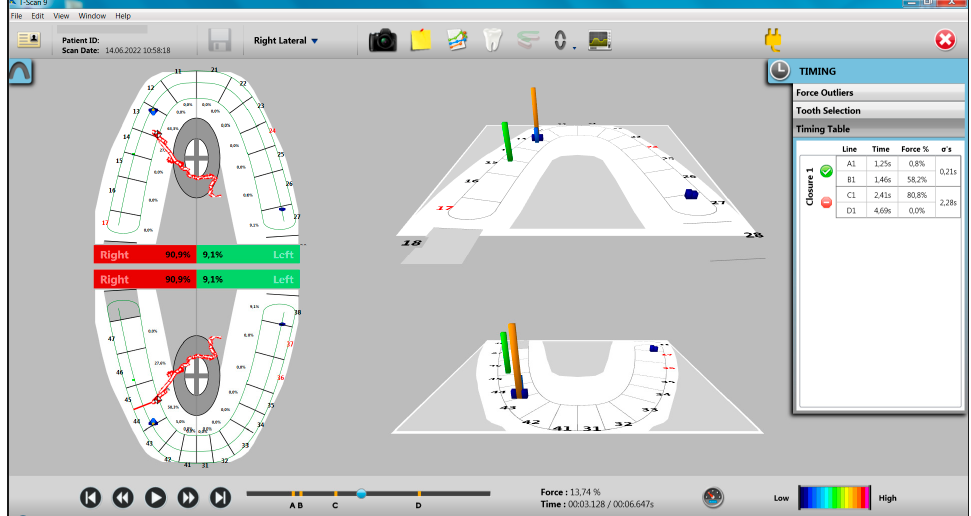
Figure 5. Aspects of T-Scan recording in right laterotrusion movement to a participant with bruxism. Canine guidance and the presence of working side interferences and non-working side interferences are noted.